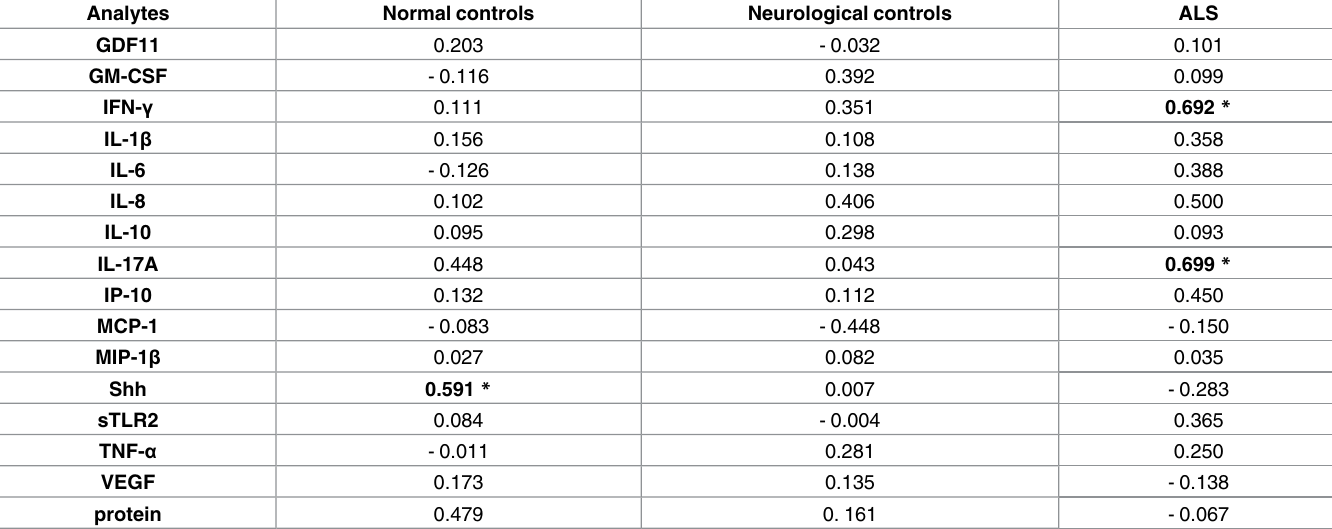
Table 3. Correlation (Spearman r) between levels of individual analytes in CSF and luminescence measuredin arbitraryunits in Shh-LTII cells cul- tured with CSF samples and rShh.